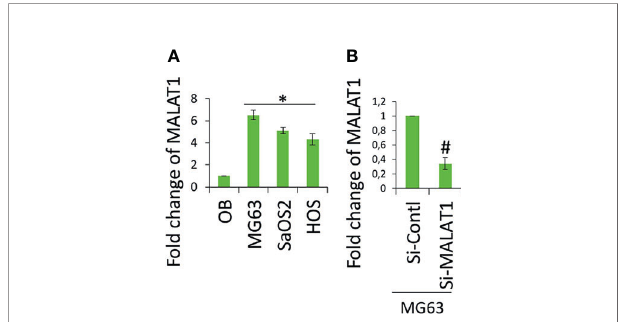
FIGURE 1 | lncRNA MALAT1 is overexpressed in OS cell lines. (A) Real-time RT-PCR was used to detect the expression level of lncRNA MALAT1 in different OS cells lines, MG63, SaOS2, and HOS, and the expression was compared with normal osteoblast differentiated from hDPSCs. Asterisk indicates signi fi cant increase compared with osteoblast. (B) Si-MALAT1 decrease MALAT1 expression in MG63 cells. Si-MALAT1/Si-control was transfected into MG63 cells, and after 24 h, the real-time RT-PCR analysis was used to detect MALAT1 expression. Number sign indicates signi fi cant decrease compared with